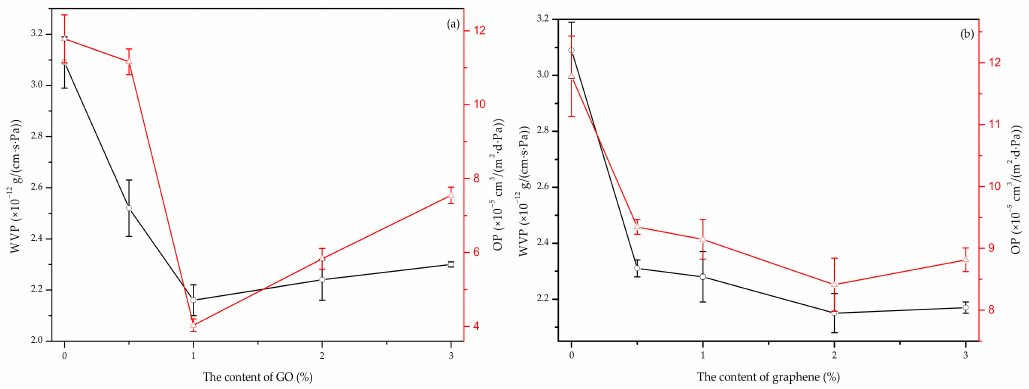
Figure 6. Water vapor permeability (WVP) and oxygen permeability (OP) values for ( a ) P-40-25 incorporated with GO and ( b ) P-40-25 incorporated with